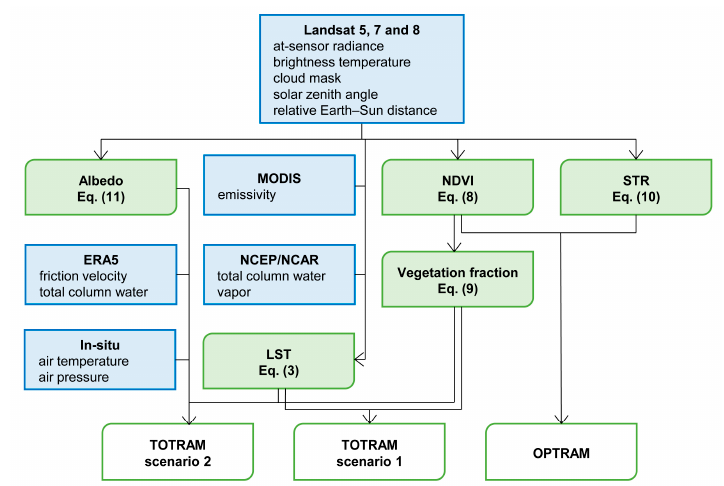
Figure 4. Data preparation for the two TOTRAM scenarios and OPTRAM. Blue-filled rectangles represent input parameters and variables and green-filled rectangles with diagonal corners rounded represent intermediate parameters and variables.